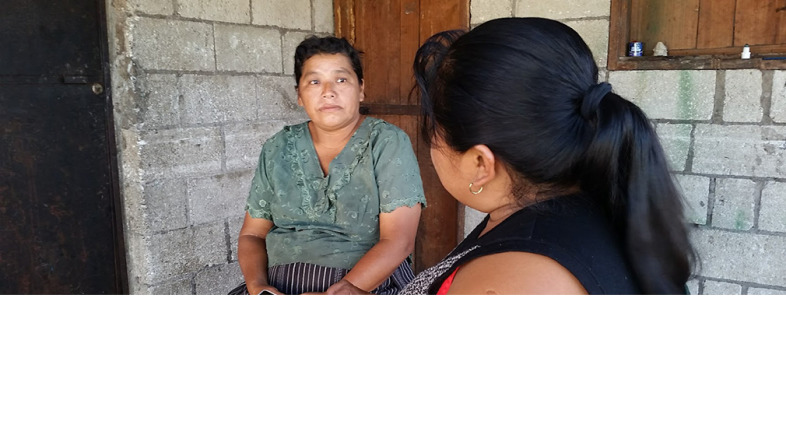
A community health worker in Guatemala conducts a home visit with a diabetes patient using a smartphone application for clinical decision support.Credit: © 2017 Sean Duffy/University of Wisconsin